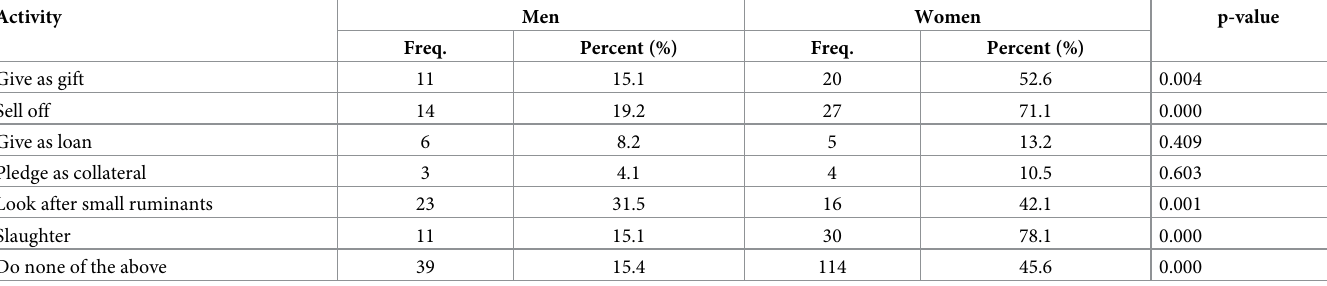
Table 2. Activities carried out by men and women on solely owned small ruminants without consultation. Activity